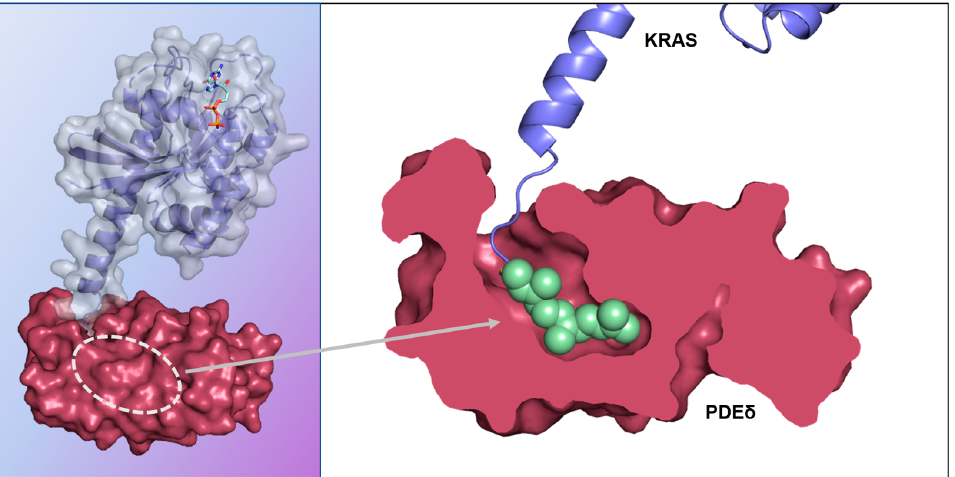
Figure 8. Co-complex X-ray crystal structure of KRAS (blue ribbon, grey surface) with PDE δ (red) (PDB 5TAR) [100]. The farnesylated C-terminus of KRAS (green) binds the prenyl binding pocket of PDE δ . The binding of ligands in this deep, hydrophobic pocket disrupts KRAS binding and thus its distribution within the cell.